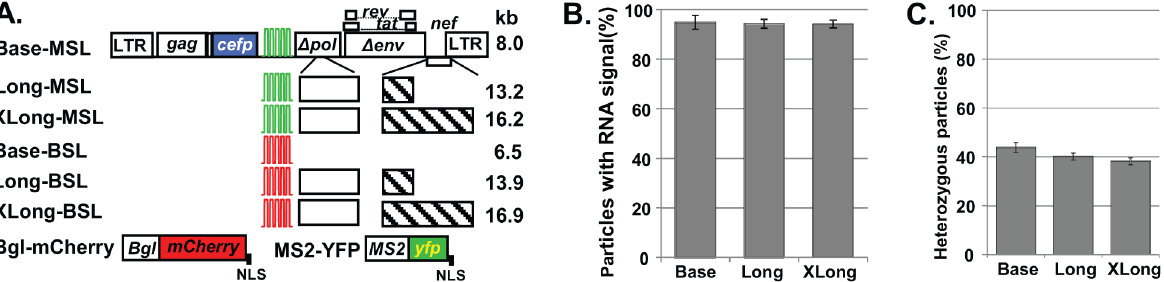
Figure 1. The ability of HIV-1 particles to package RNAs larger than 9 kb. (A) General structure of constructs. Green and red stem-loops represent binding sites for MS2 coat protein and BglG protein, respectively; white and hatched boxes denote HIV-1 and nonviral sequences, respectively; LTR, long terminal repeat; NLS, nuclear localization signal. (B) Packaging efficiencies of HIV-1 RNAs from Base, Long, and XLong constructs. Data shown are the mean 6 standard deviation (SD) from $ 8 independent experiments. (C) Proportions of heterozygous particles generated by Base, Long, and XLong constructs. Data shown are the mean 6 SD from $ 3 independent experiments.